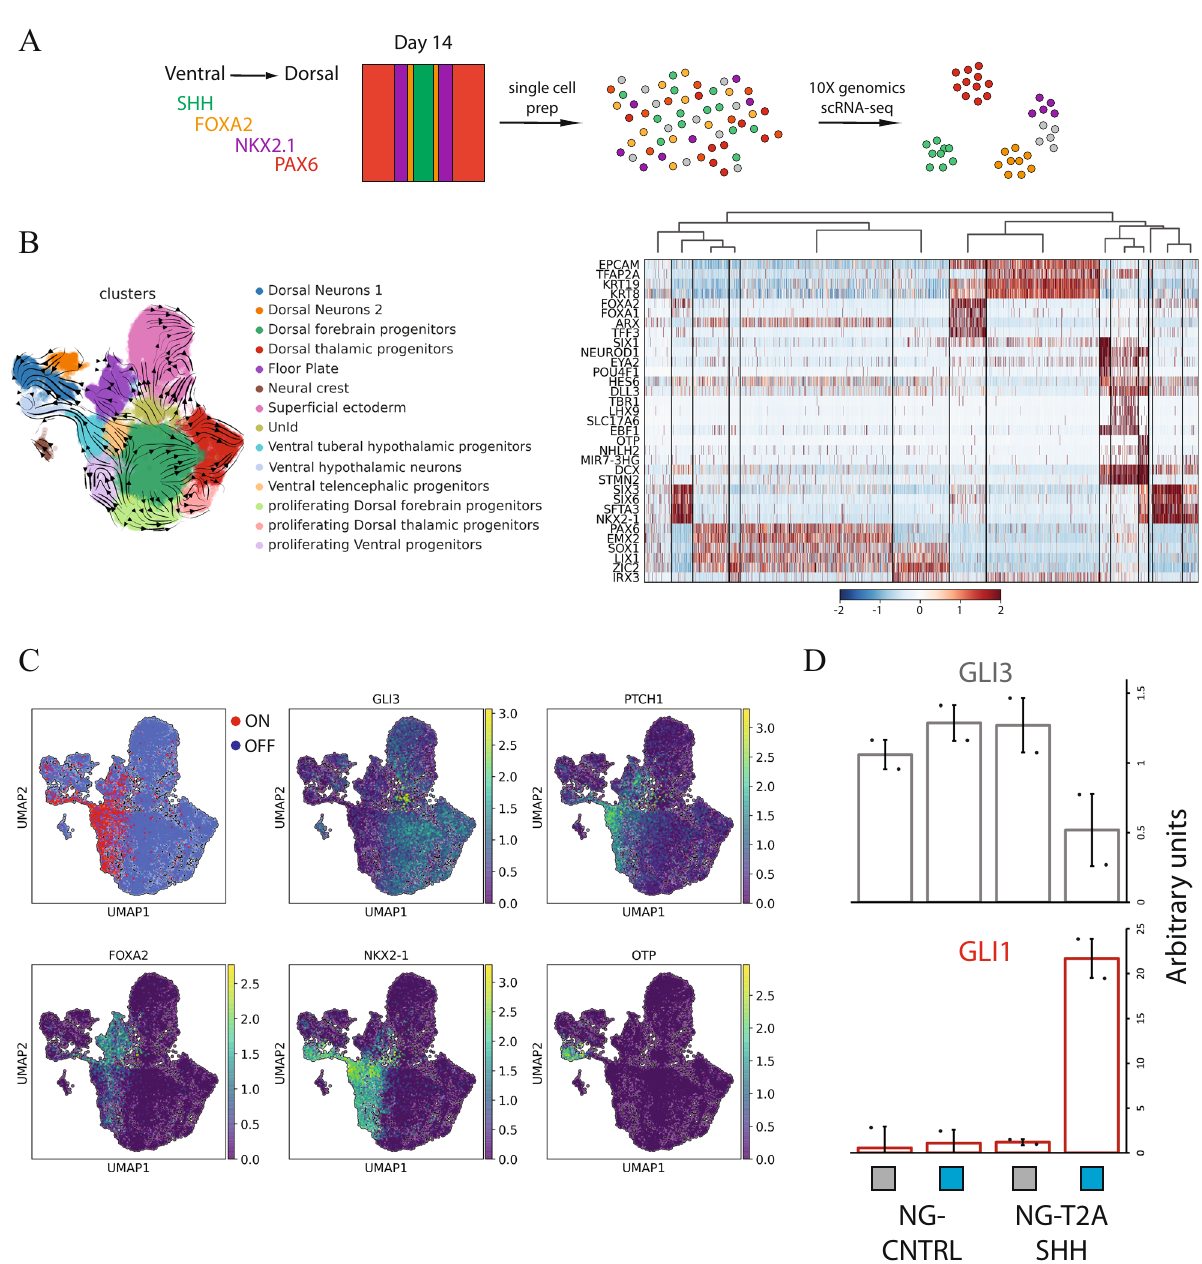
Fig. 3 scRNA-seq characterization of light-induced SHH neural cells. A Schematization of the scRNA-seq pro fi ling strategy. B Left panel: UMAP plot labeled with the identi fi ed cell identities and RNA velocity vectors: (i) FOXA2 + /ARX Floor Plate, (ii) NKX2-1 + /RAX + /SIX6 + Ventral tuberal hypothalamic progenitors, (iii) NKX2-1 + /FOXG1 + Ventral telencephalic progenitors, (iv) NKX2-1 + /NHLH2 + /OTP + Ventral hypothalamic neurons, (v) TFAP2A + /KRT19 + Super fi cial ectoderm, (vi) SOX10 + /PLP1 + Neural Crest, (vii) PAX6 + /EMX2 + /OTX2 + Dorsal forebrain progenitors, (viii) IRX3 + /OLIG3 + Dorsal thalamic progenitors, (ix) TBR1 + /LHX1 + Dorsal Neurons_1, (x) HES6 + /DLL3 + Dorsal Neurons_2, dorsal and ventral proliferating progenitors, (xi) Dorsal, (xii) Dorsal thalamic, (xiii) Ventral and (xiv) an UnIdenti fi ed population (UnId). Right panel: z-score scaled heatmap of marker genes used for cell identities classi fi cation. C UMAP plot displaying SHH responsive and unresponsive status, and GLI3 and PTCH1 expression level. SHH responsive and unresponsive status have been computed imposing a threshold based on the normalized distribution of GLI3, GAS1 and PTCH1 counts, where GLI3-GAS1 low and PTCH1 high represent SHH responsive while GLI3-GAS1 high , PTCH1 low unresponsive. D qRT-PCR analysis of SHH responsive genes (GLI1 and GLI3) for NG- T2A-SHH and NG-CNTRL at day 14 of differentiation. The histogram displays the average and SD of differentiated cells exposed to light stimulation or dark control ( n = 2 biologically independent samples). placode and epidermis that organize in radially symmetrical inhibition leads to self-organization of telencephalic neural pro- patterns 34 . In the context of the ectoderm, this type of self- genitor around a lumen generating rosette (cerebroids) 34,47 . When Dual SMADs inhibition is followed by BMP4 presentation, organization re fl ects the events that occur in the dorsal anterior con fi ned hESCs colonies self-organize to generate the four deri- part of the developing CNS. As for spatial geometrical con fi ne- vatives of the ectodermal layers: neural, neural crest, sensory ment that provided the key element for gastruloid, cerebroid and